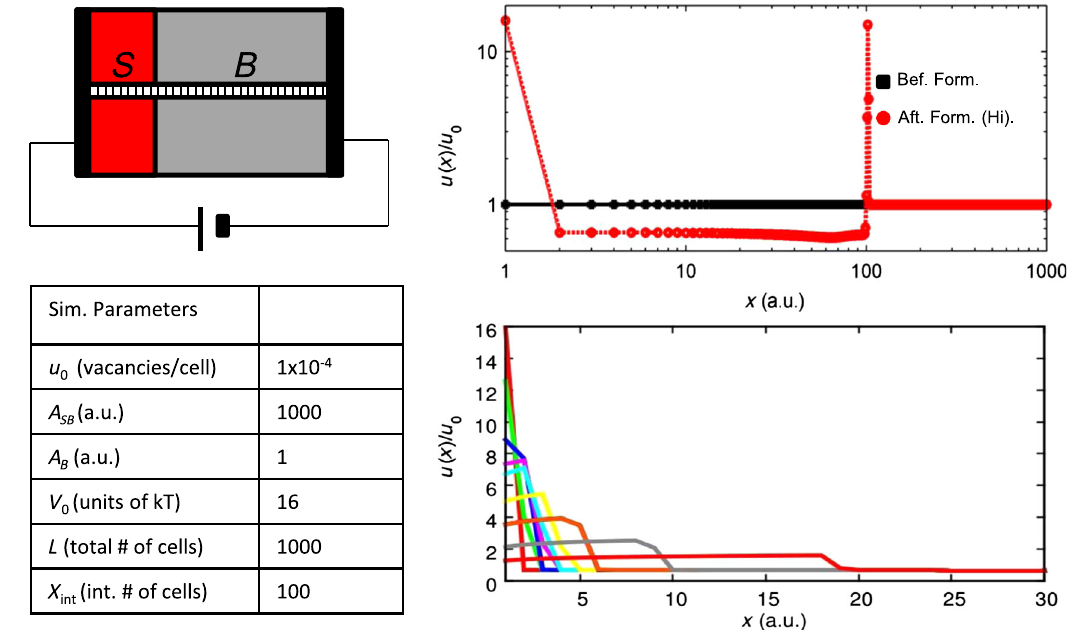
FIG. 6. Top-left panel: Schematic diagram of the VEOVM model with a single active contact. The two regions SB and B correspond to the high-resistance interface (Schottky barrier) and the more conductive central bulk, respectively. The small cells within the channel indicate the domains. Top-right panel: Vacancy distribution along the conductive channel before (black squares) and after (red circles) the forming process. The distribution shown after the forming process corresponds to a HI resistance state. Starting from a uniform distribution, during the forming process a characteristic distribution is obtained where vacancies initially at the interface migrate to the low-field bulk region, generating a pileup of vacancies close to the limit between the two regions. In the HI state, some of these vacancies migrate back to the interfacial region and are accumulated in the vicinity of the metal contact. Bottom left (table): parameters used in the simulations. Bottom-right panel: Snapshots of the shock-wave formation in the early stage of simulations (between the first and second snapshots of Fig.